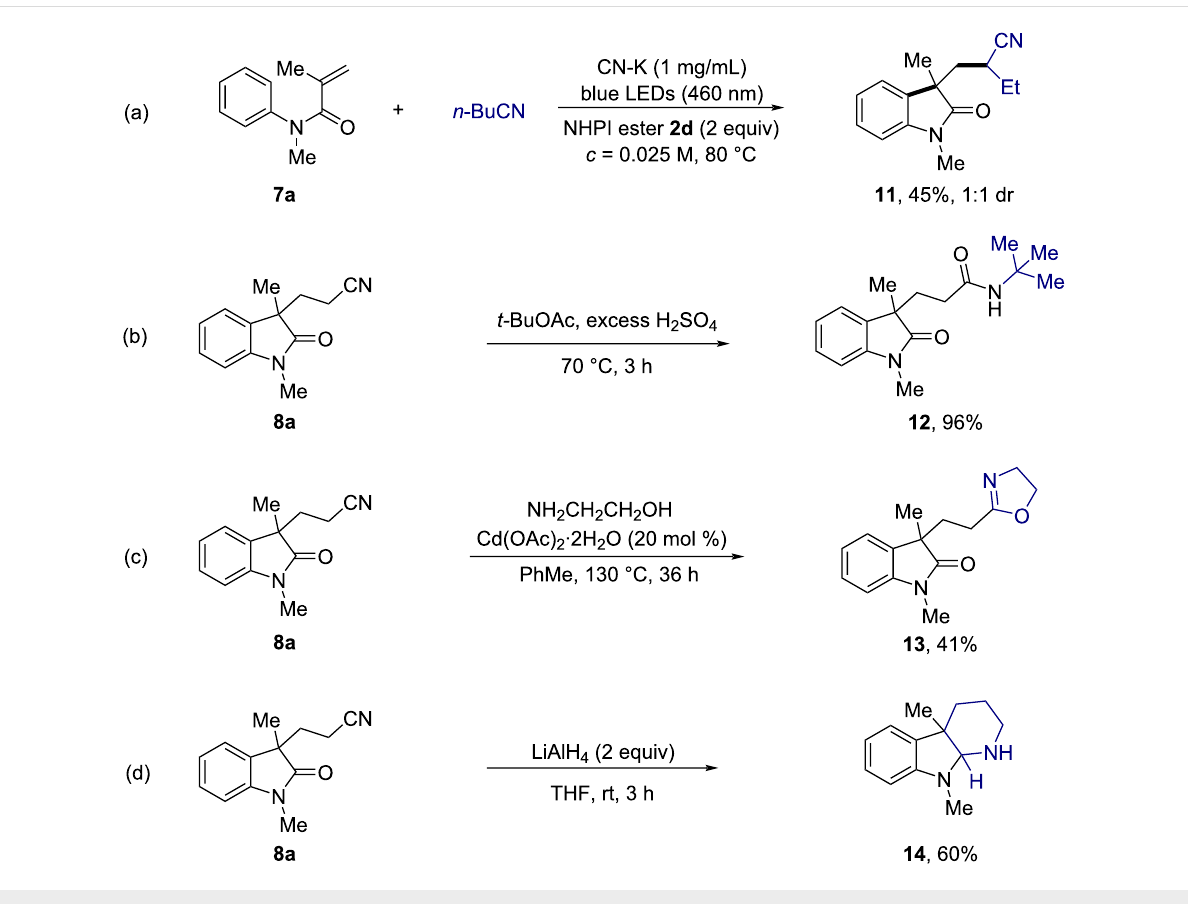
Scheme 6: Further survey of reaction scope and derivatization studies of 8a